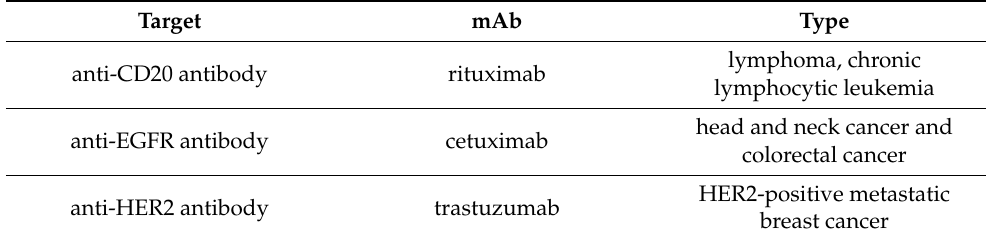
Table 3. Clinically approved